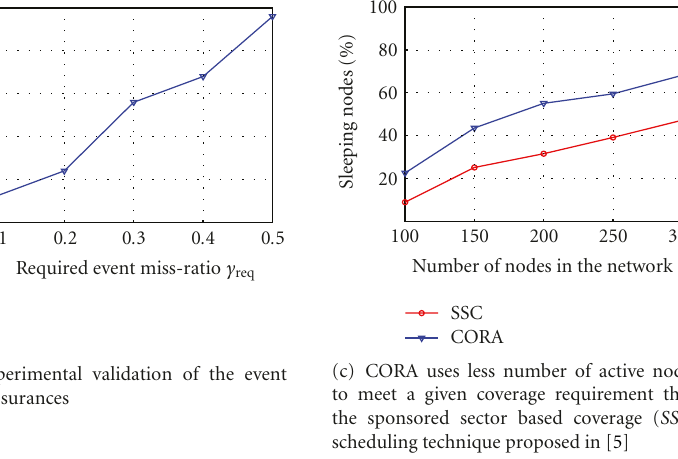
Figure 8: Performance evaluation of coverage